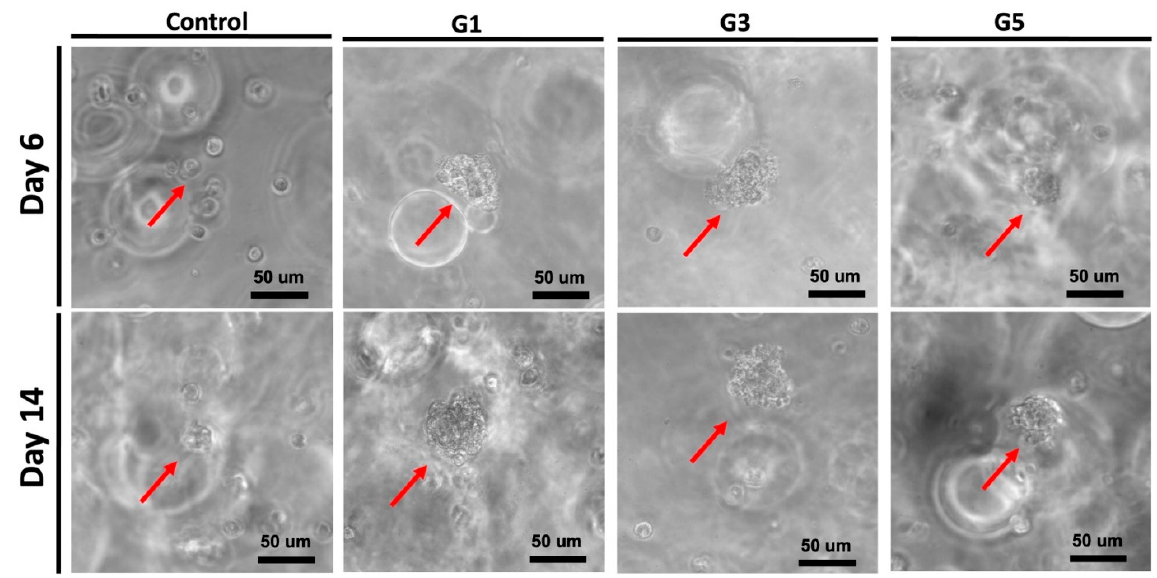
Figure 3. Potential clustering behavior of NSCs encapsulated in four different hydrogels on day 6 and day 14. Red arrows represent the neuro-clusters.